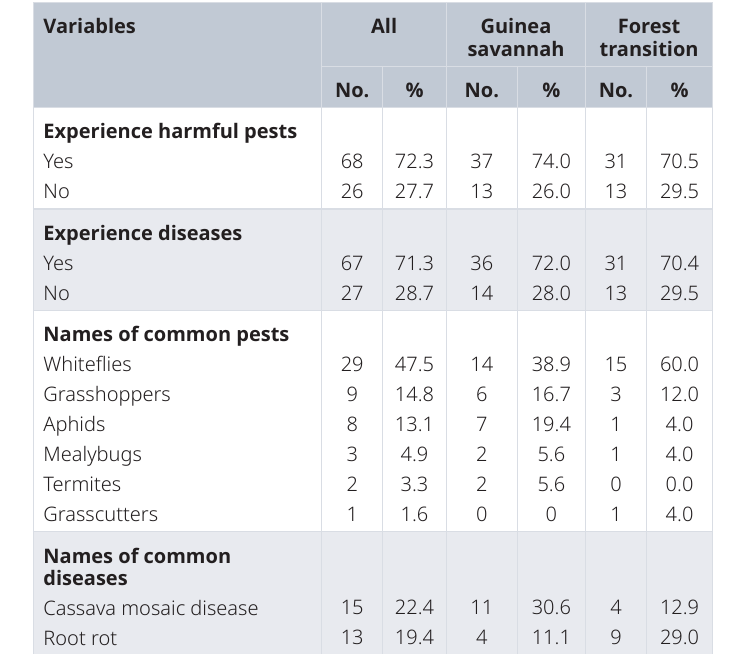
Table 3. Farmers’ knowledge of cassava pests and